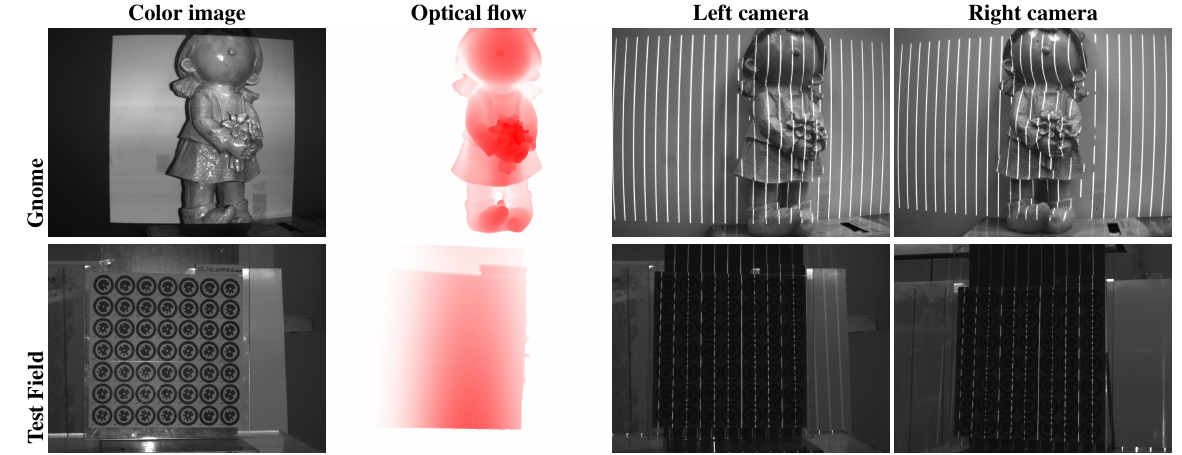
Figure 4. Examples from the ZebraScan Real dataset.